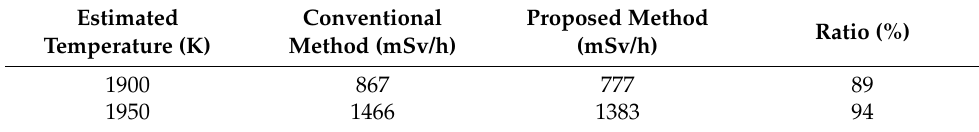
Table 4. Comparison of radiation dose